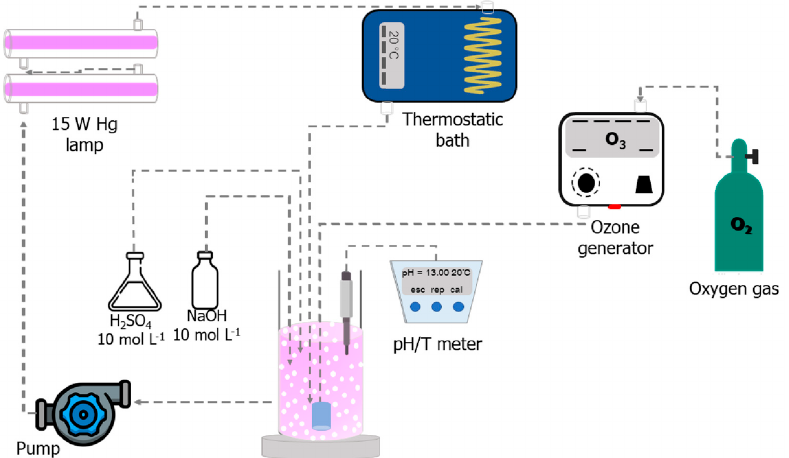
Figure 3. Semi-batch ozone-based advanced oxidation process diagram for the degradation of AMX in pharmaceutical formulation wastewater.